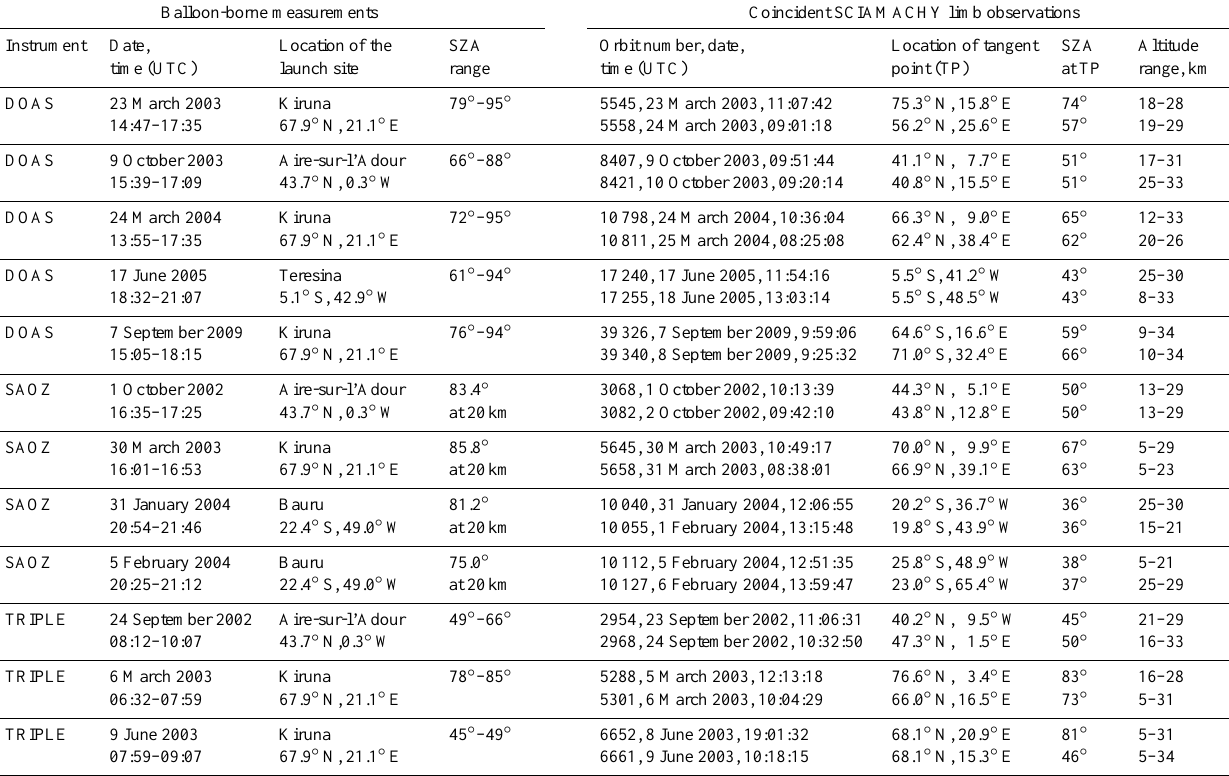
Table 2. Balloon-borne measurements performed with DOAS, SAOZ, and TRIPLE instruments as well as coincident SCIAMACHY limb observations. The information is partially from Table 1 in Dorf et al.